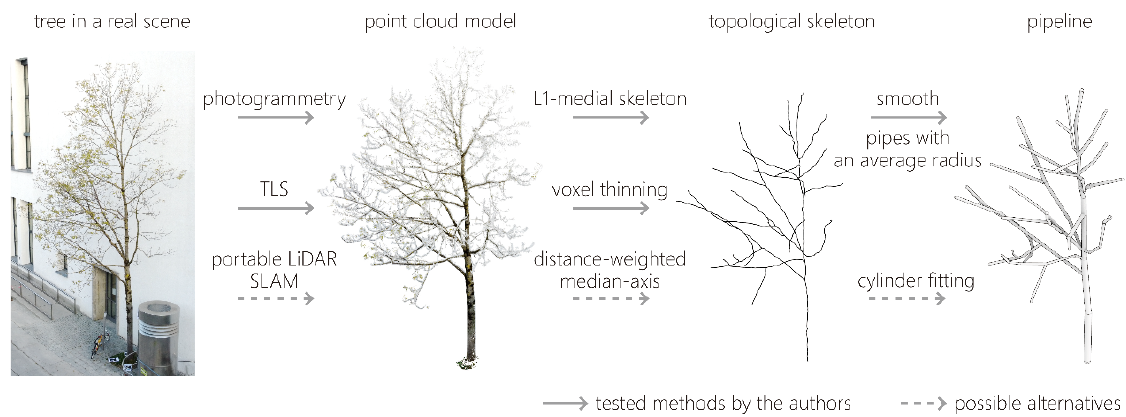
Figure 4. Process to collect topological geometry data of the tree trunk and branches.